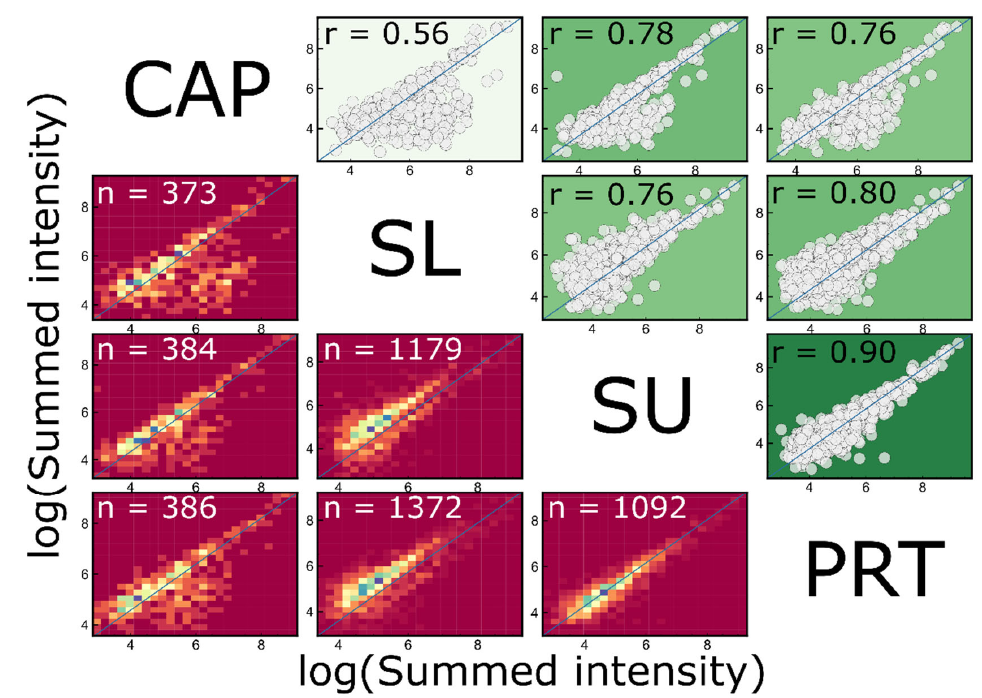
Figure 2. Correlation of intensities of proteins in different pooled samples. The depth of the back- ground colors of scatter points on top-right is proportional to the value of actual Pearson correlation coefficients, which are shown on the 2D histograms at bottom-left. The number of the common sets of proteins ( n ) are given.